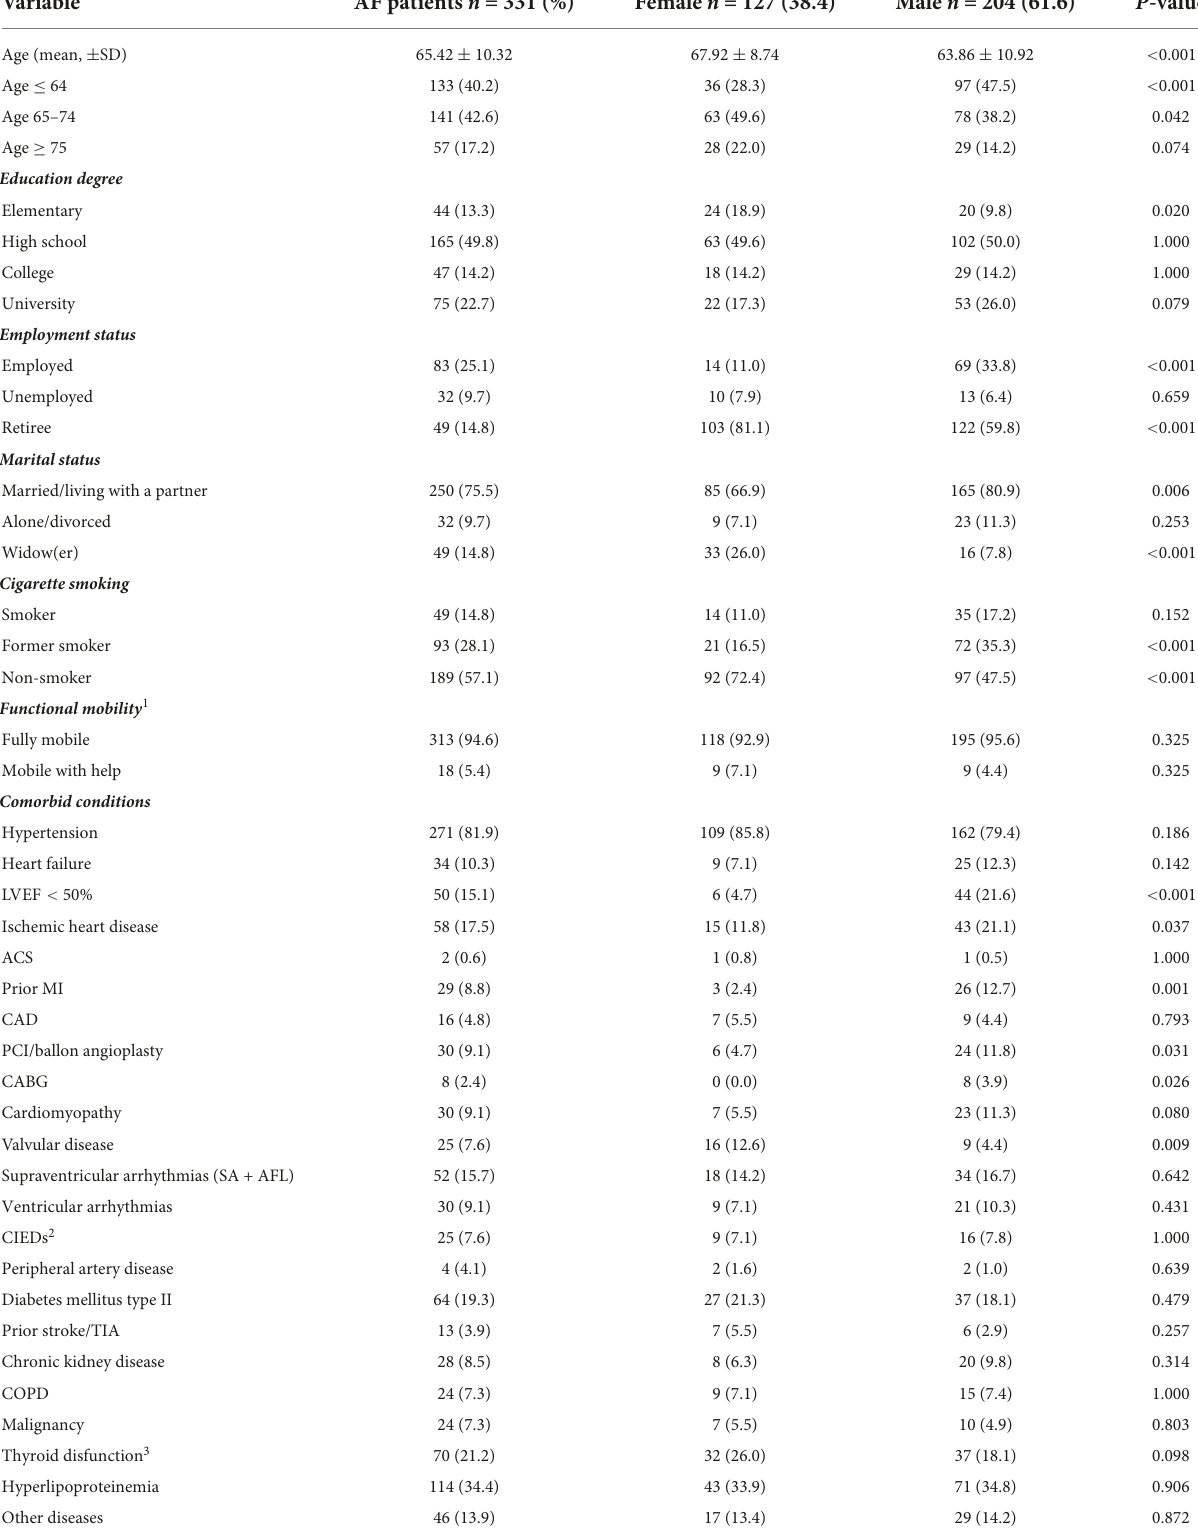
TABLE 1 Sex differences in socio-demographic characteristics of the study cohort, concomitant comorbidity and current medication in atrial fibrillation (AF) patients. Variable AF patients n = 331